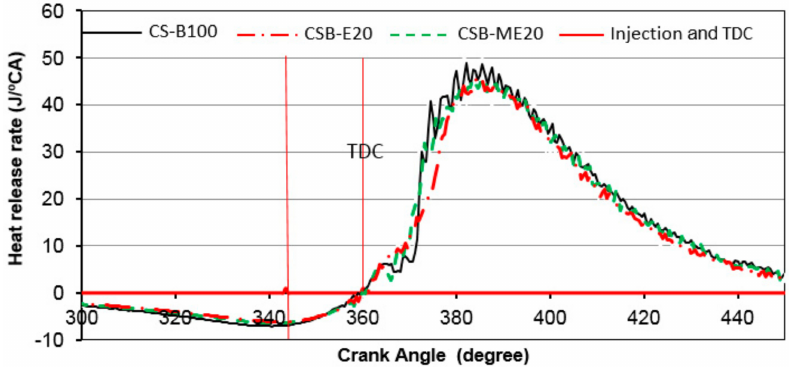
Figure 4. Heat release rate (J / ◦ CA) at an engine speed of 3670 rpm.